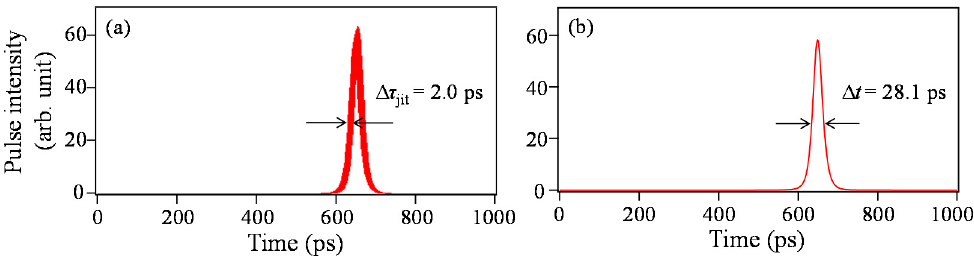
Figure 4. ( a ) Superimposed temporal waveform of 2000 pulses and ( b ) the corresponding averaged waveform with Langevin noise included.